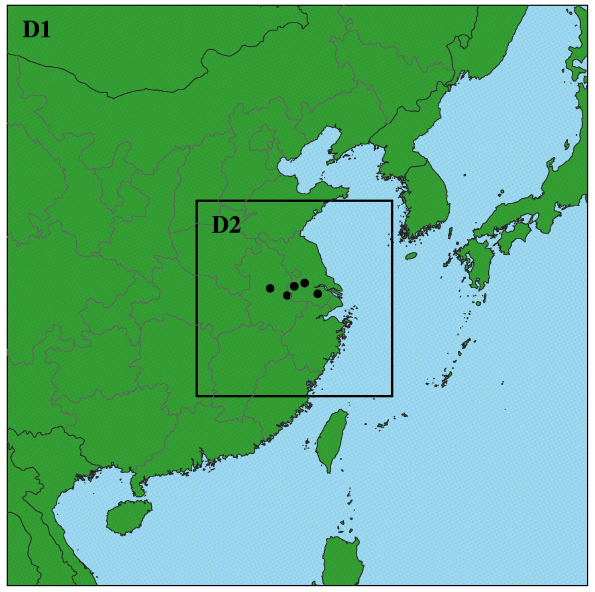
Figure 1. Map of the two model domains. The locations of the observation sites used for model evaluation are presented as dots. From west to east, the sites are located in Hefei, Maanshan, Nan- jing, Zhenjiang, and